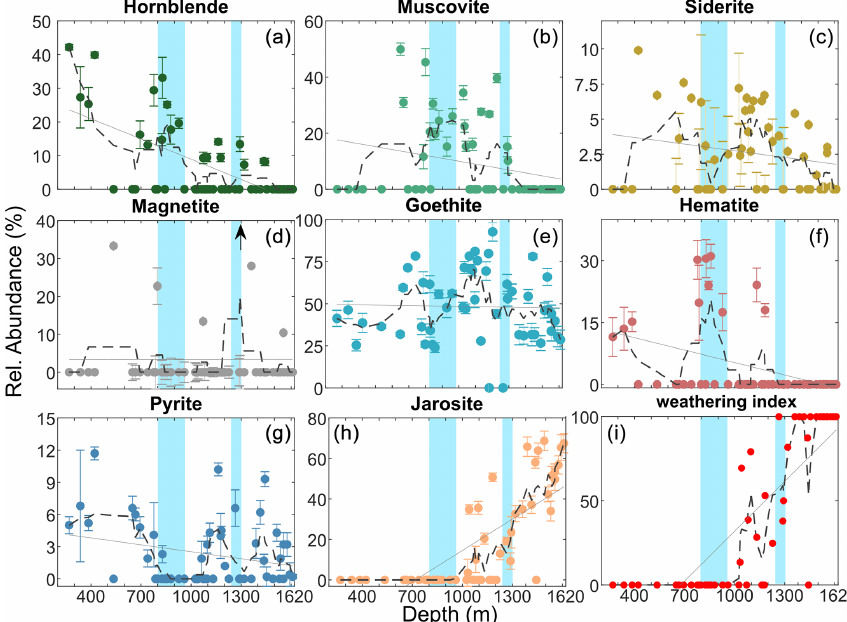
Figure 6. The variation in the major Fe-bearing minerals in TALDICE dust with depth. Dashed lines correspond to a 5-point moving average and solid grey lines to linear trends. In panel (d) , one sample point is off the scale (black arrow, magnetite relative abundance 70%). Panel (i) shows the weathering index, defined as the percent ratio between jarosite concentration and the sum of jarosite, hornblende, muscovite and